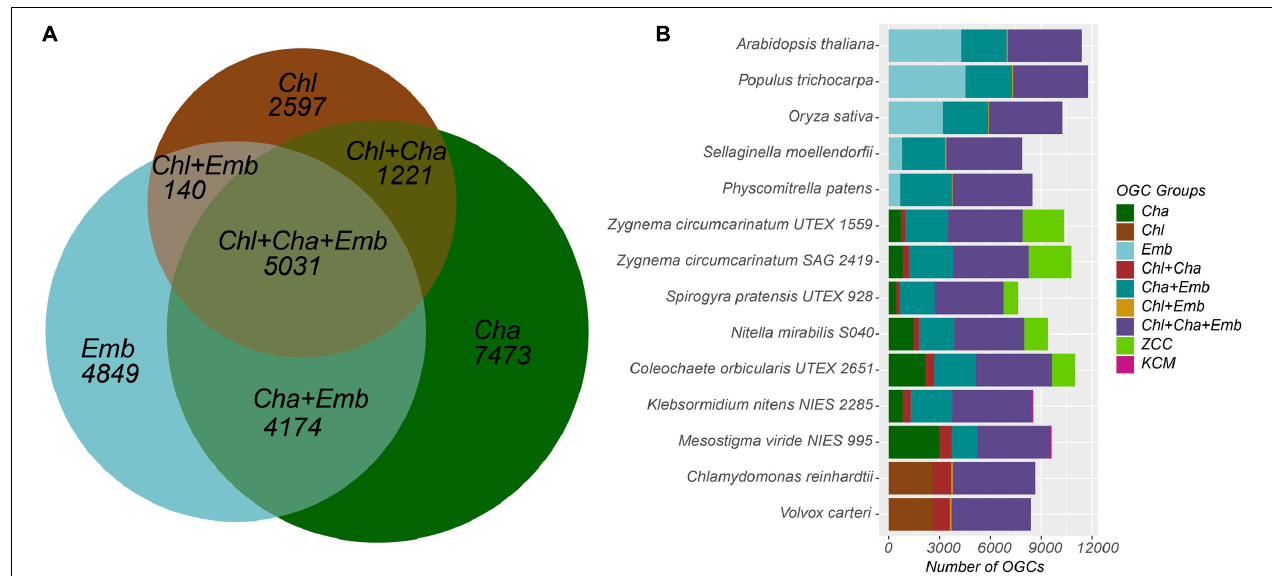
FIGURE 1 | Distribution of the nine OGC groups in the 14 species. (A) The Venn diagram shows the numbers of OGCs shared by and unique to the three major plant/algal taxonomic groups. The 7473 OGCs unique to the Cha group are the sum of three OGC numbers (3600+3807+66) in Table 3 . Note that the sizes of the seven areas in the diagram are proportional to the number of OGCs and not to the number of proteins. For example, the number of proteins in the Chl+Cha+Emb group is 115,769, which is the largest in Table 3 . (B) For each species, the 25,485 OGCs were examined to see if there is a protein from that species. Then the OGC counts for that species were plotted with different OGC groups presented in different colors. The species labels in the y axis are arranged according to the phylogenetic relatedness. Note that the x-axis shows the number of OGCs not the number of proteins.